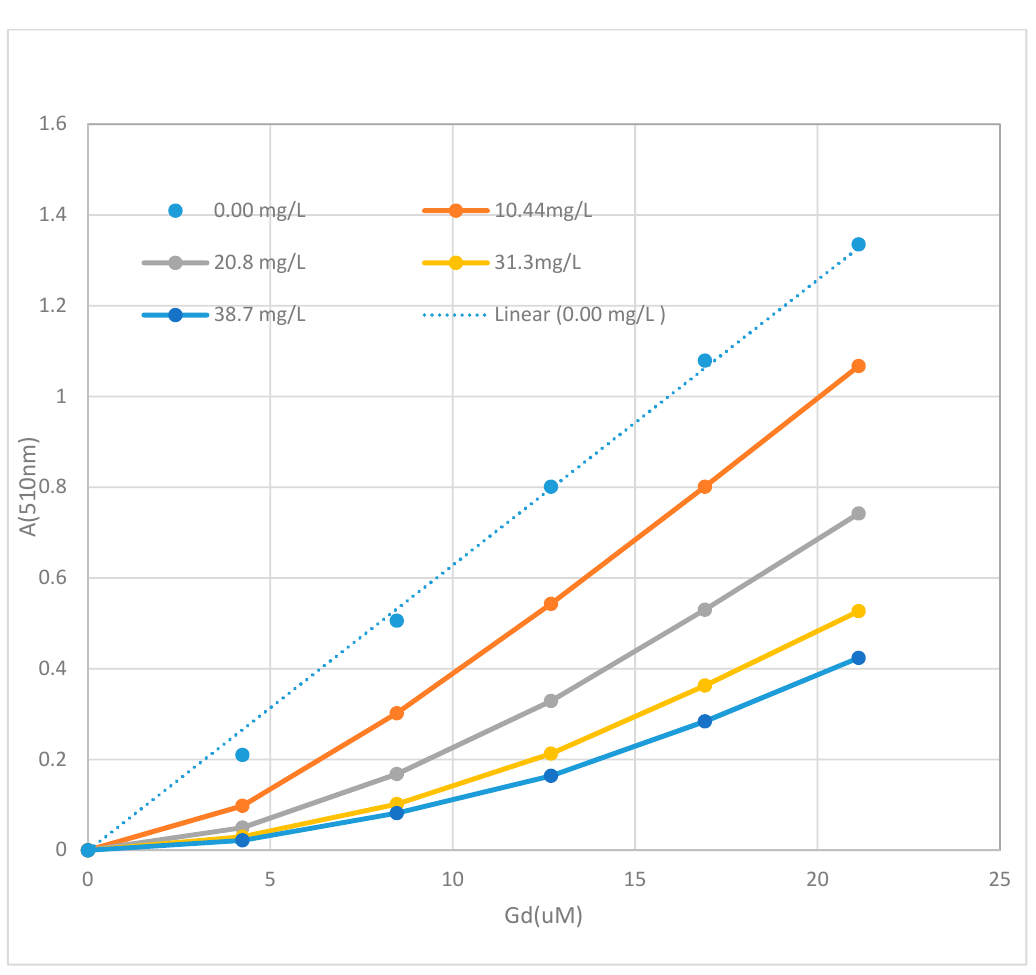
Figure 6. The Gd 3+ titration data for the IHSS Leonardite humic acid at pH 8 and at different humic acid concentrations. The curvature is interpreted as a finite complexing capacity for the humic acid.